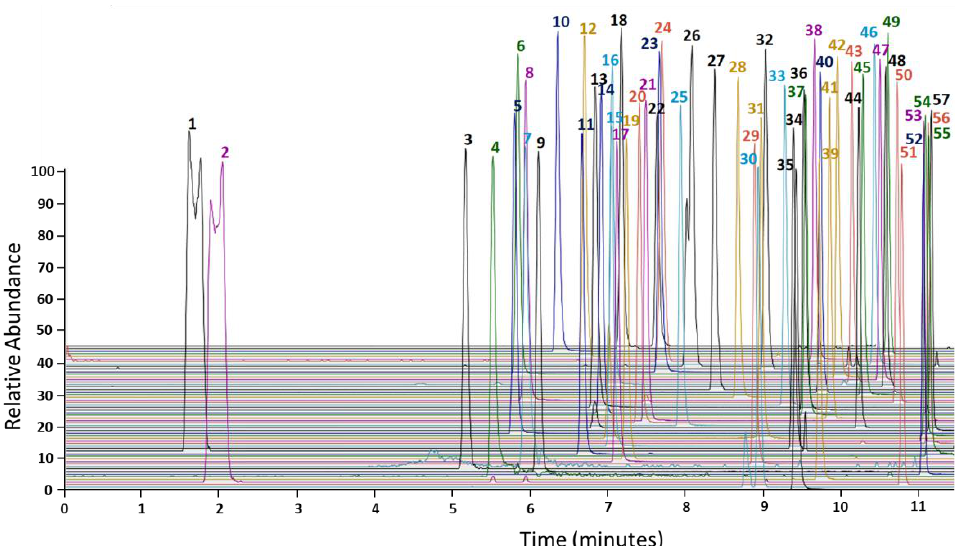
Figure 1. Overview of all 57 separated oral anticancer drugs. Combined representation of individual chromatograms. 100% relative abundance corresponds to the maximum peak height of each com- pound. Lenalidomide (1), trifluridine (2), pomalidomide (3), thalidomide (4), ribociclib (5), brigatinib (6), panobinostat (7), gefitinib (8), rucaparib (9), abemaciclib (10), lorlatinib (11), afatinib (12), imatinib (13), lenvatinib (14), vandetanib (15), crizotinib (16), niraparib (17), dacomitinib (18), neratinib (19), palbociclib (20), osimertinib (21), ruxolitinib (22), bosutinib (23), anagrelide (24), pazopanib (25), axitinib (26), dasatinib (27), erlotinib (28), olaparib (29), vinorelbine (30), sunitinib (31), binimetinib (32), idelalisib (33), larotrectinib (34), vismodegib (35), lapatinib (36), nilotinib (37), alectinib (38), tivozanib (39), encorafenib (40), nintedanib (41), cabozantinib (42), cobimetinib (43), ponatinib (44), enzalutamide (45), apalutamide (46), ceritinib (47), dabrafenib (48), abiraterone (49), ibrutinib (50), venetoclax (51), sonidegib (52), trametinib (53), sorafenib (54), midostaurin (55), vemurafenib (56), regorafenib (57).